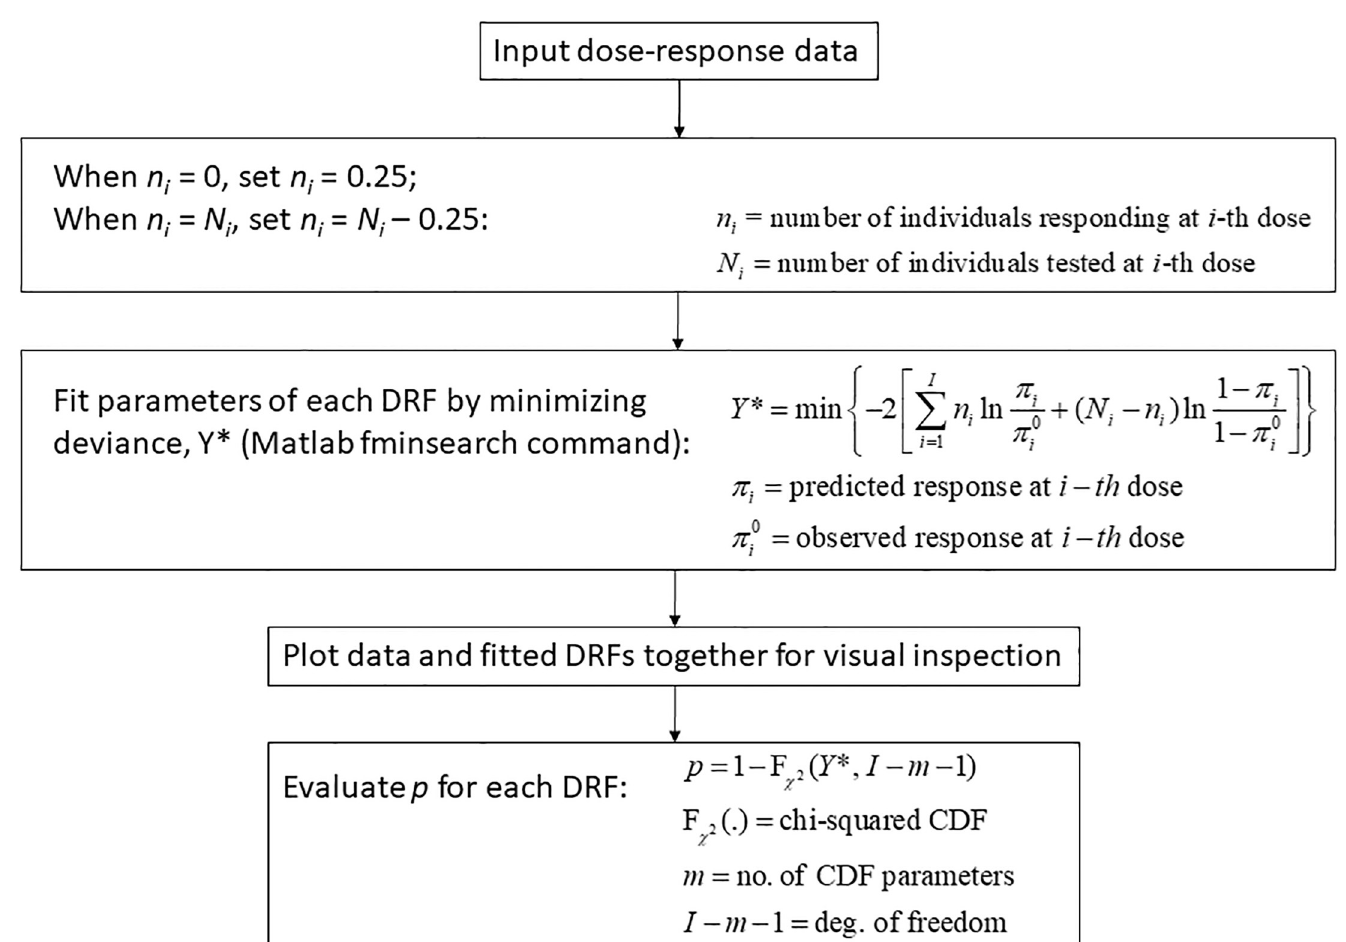
Fig 1. Diagram illustrating the procedure for data